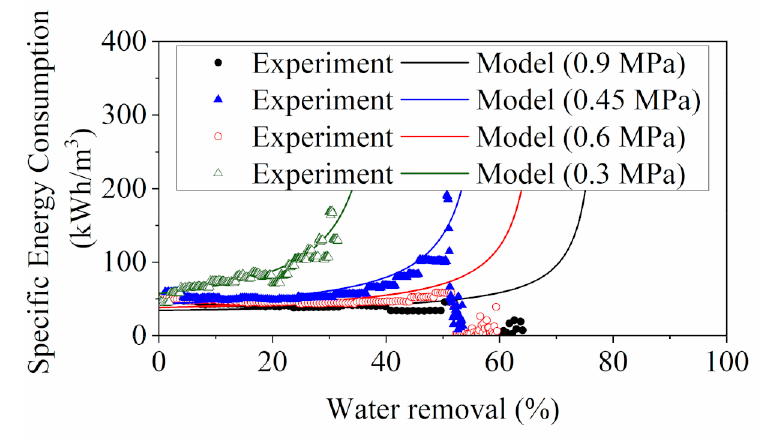
Figure 7. Comparison of the SEC computed from lab measurements (experiment SEC) and the model SEC.